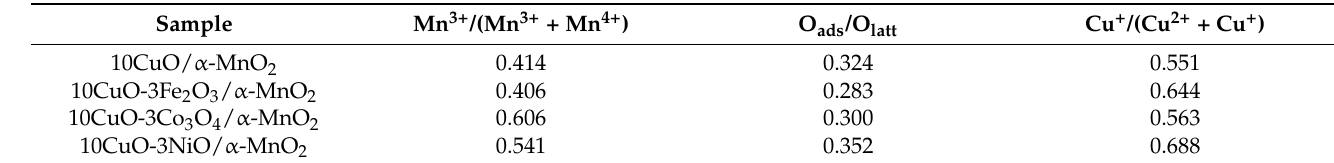
Figure 4. ( a ) Mn 2p spectra, ( b ) O 1s spectra, and ( c ) Cu 2p spectra of the 10CuO/ α -MnO 2 , 10CuO- Table 2. The ratio of Mn 3+ /(Mn 3+ + Mn 4+ ), O ads/ O latt , and Cu + /(Cu 2+ + Cu + ) of the 10CuO-3MOx/ α - MnO 2 (MOx = Fe 2 O 3 , Co 3 O 4 , NiO) and the 10CuO/ α -MnO 2 catalyst.